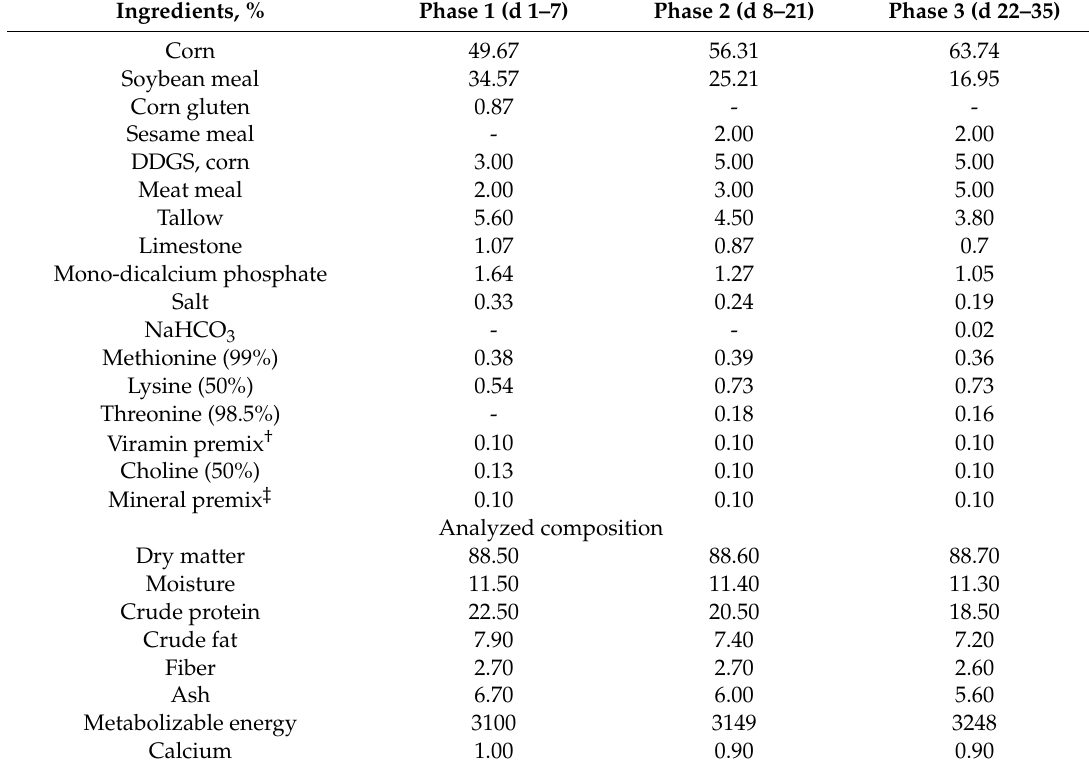
Table 2. Ingredient composition of experimental diets (basal